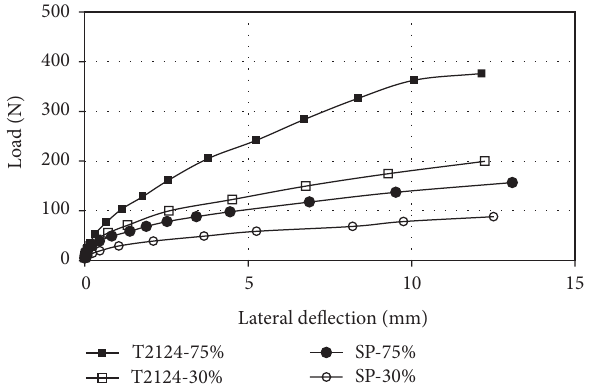
Figure 7: Lateral load versus lateral deflection (2 × 2 pile group; 𝑠/𝑑 = 6 ).